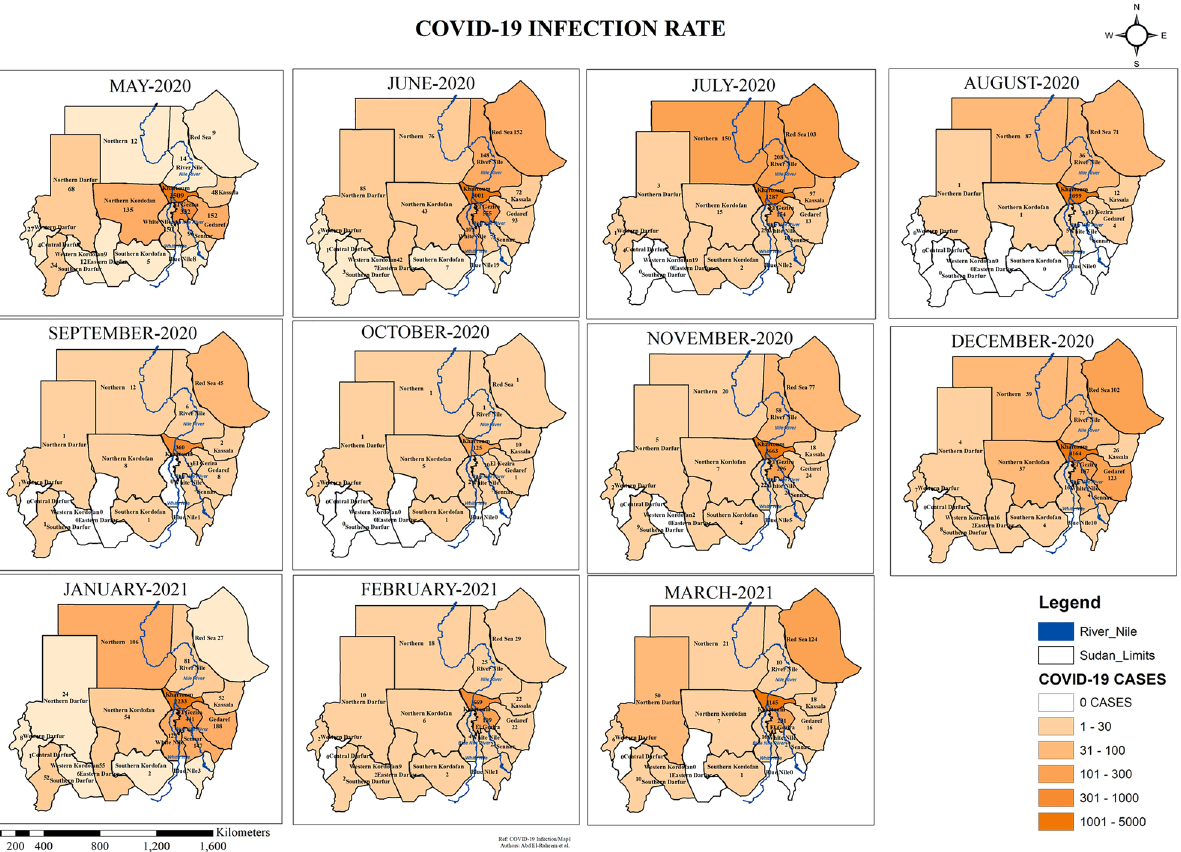
Figure 1. COVID-19 Infection rate across the states of Sudan May 2020–March 2021 developed through ArcGIS 10.8 by Abd El-Raheem et al. (Shp. files of the base maps https:// www. diva- gis. org/